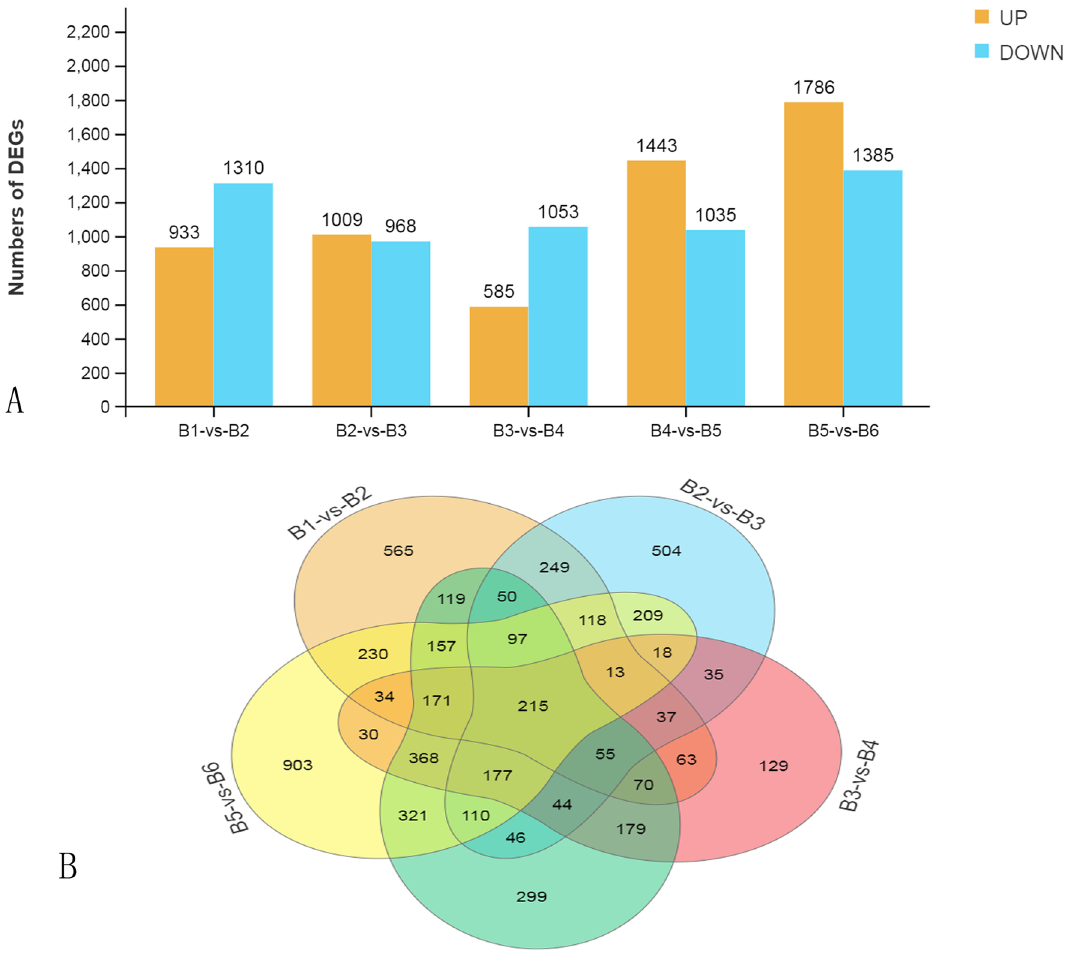
Figure 3. Differentially expressed genes across various developmental stages. ( A ) Histogram of differentially expressed genes. ( B ) Venn diagrams of differentially up-regulated